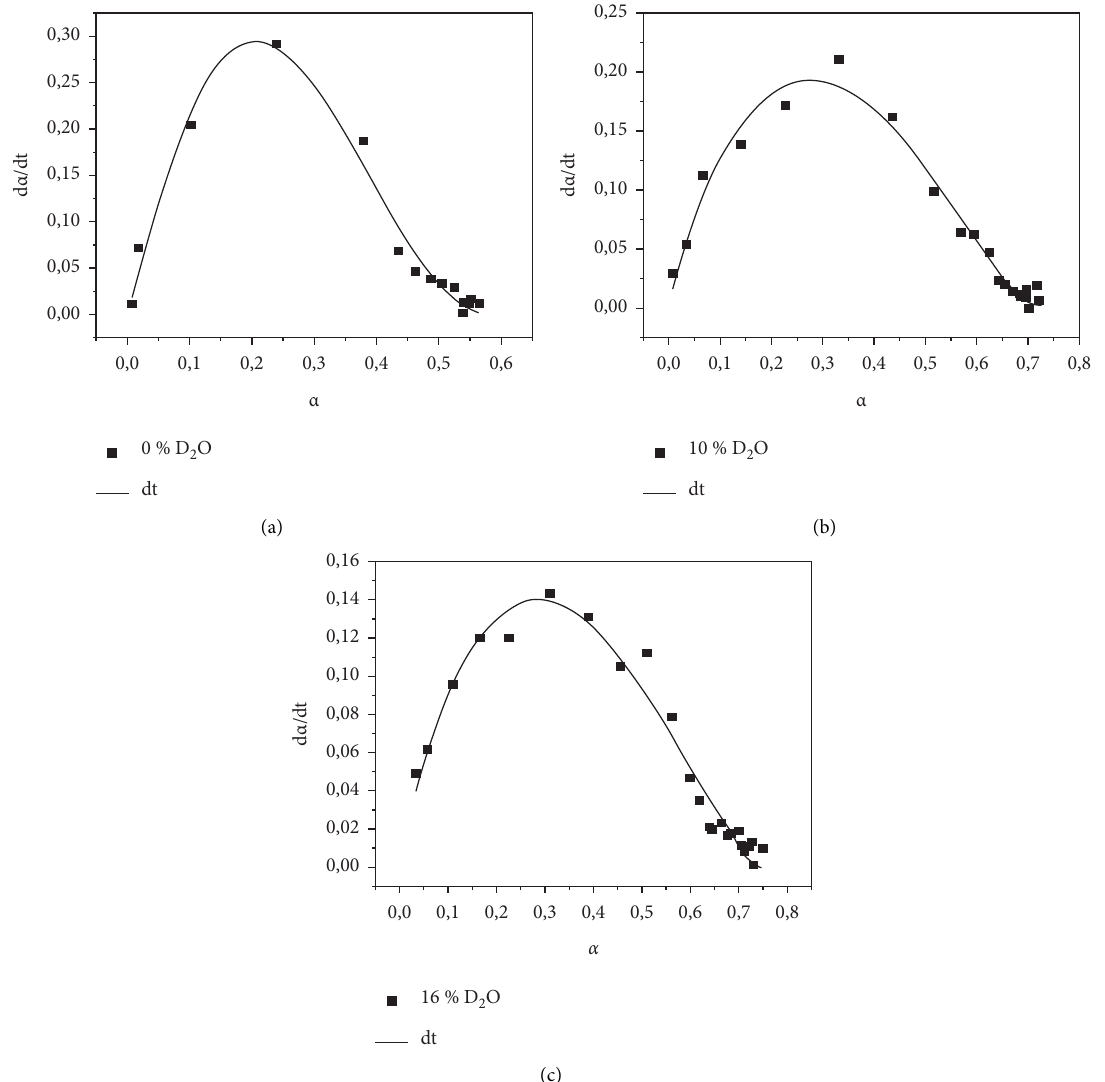
2 O in their formulation.